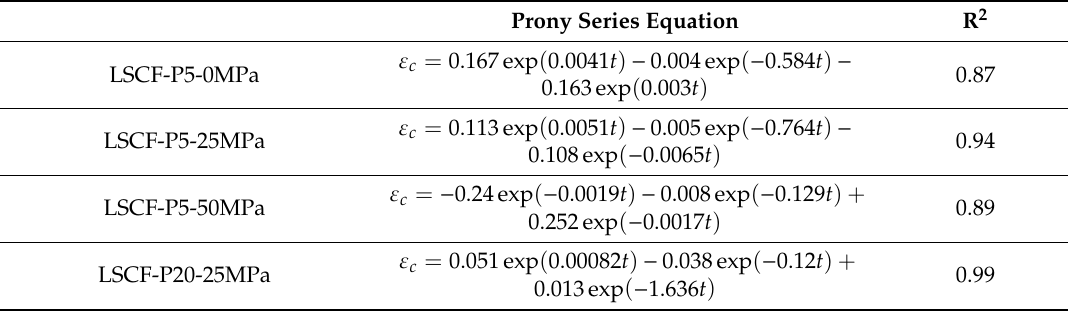
Figure 9. Comparison of axial creep deformation of LSCF-P5 samples under 0, 25 and 50 MPa and LSCF-P20 under 25-MPa maximum load stress and LSCF-P20 sample under 25-MPa maximum stress fitted with Prony series equation. Table 2. Prony series equation description of axial creep